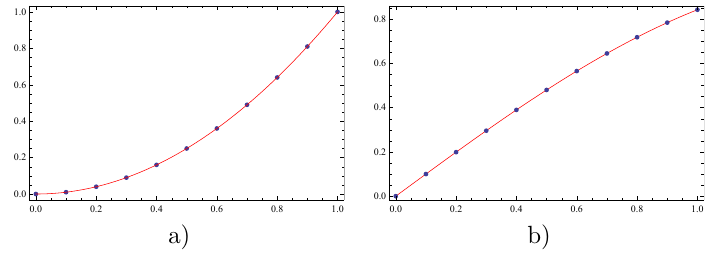
Figure 1. Approximate solutions: a) Example 1, b) Example 2.